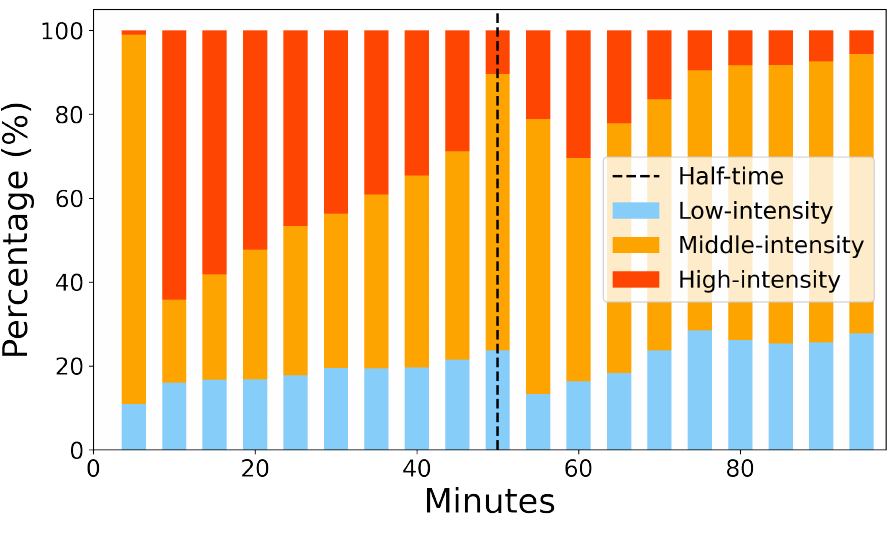
Figure 8. High-, middle-, and low-intensity cluster distribution across a period of a game in 5 min